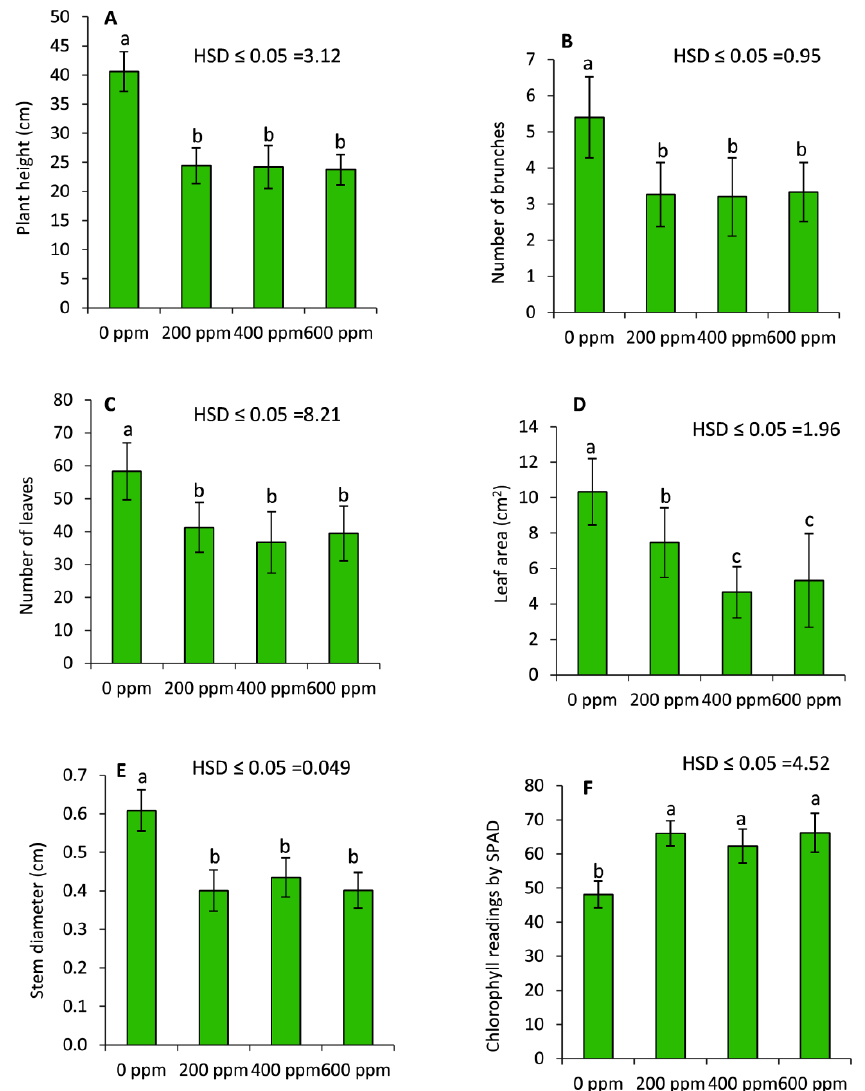
Figure 1. Effect of paclobutrazole (PBZ) on the vegetative growth of lavender plants and chlorophyll readings by SPAD. Values are the averages of 15 plants ± SD. Different letters indicate significant differences according to Tukey’s Studentized Range (HSD) Test ( p < 0.05).